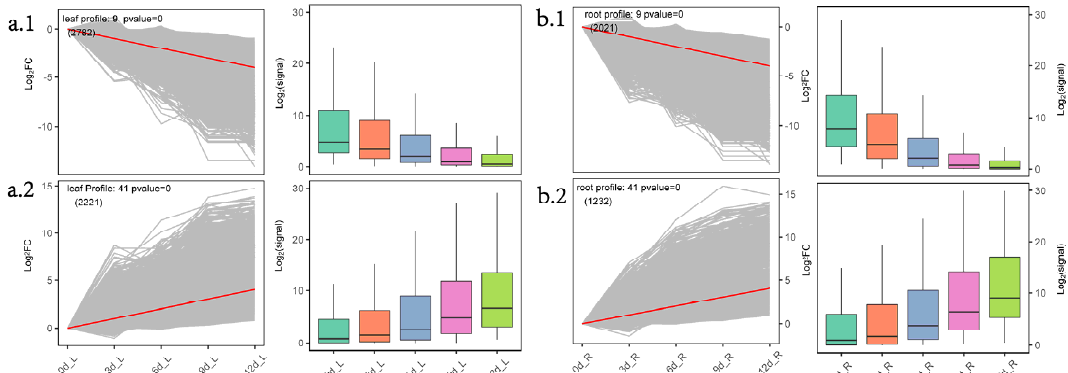
Figure 4. Cluster analysis of gene expression trends during drought stress in P. massoniana. ( a.1 ) and ( a.2 ): Two STEM significance modules (needle Profile9 and needle Profile41) of the needles during drought stress; ( b.1 ) and ( b.2 ): Two short time-series expression miner (STEM) significance modules (root Profile9 and root Profile41) of the roots during drought stress. Note: We used STEM software to perform trend clustering analysis and divided the trends into 5 stages according to the time before and after input and normalized the union of all the combined DEGs from the five stages. The left side of each subfigure is the significant module selected in the STEM analysis; the right side is the box plot of the corresponding gene expression after taking the logarithm.